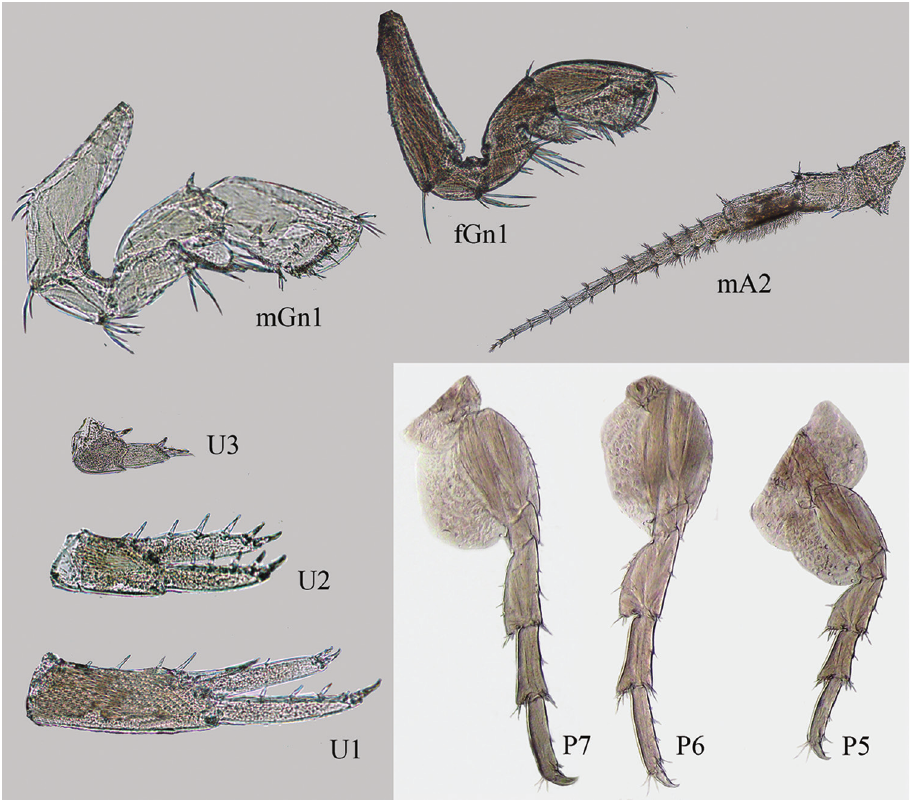
Figure 3. Ptilohyale littoralis , antenna II male (mA2), gnathopod I male (mGn1), gnathopod I female (fGn1), peraeopods V (P5), VI (P6) and VII (P7), uropods I (U1), II (U2) and III